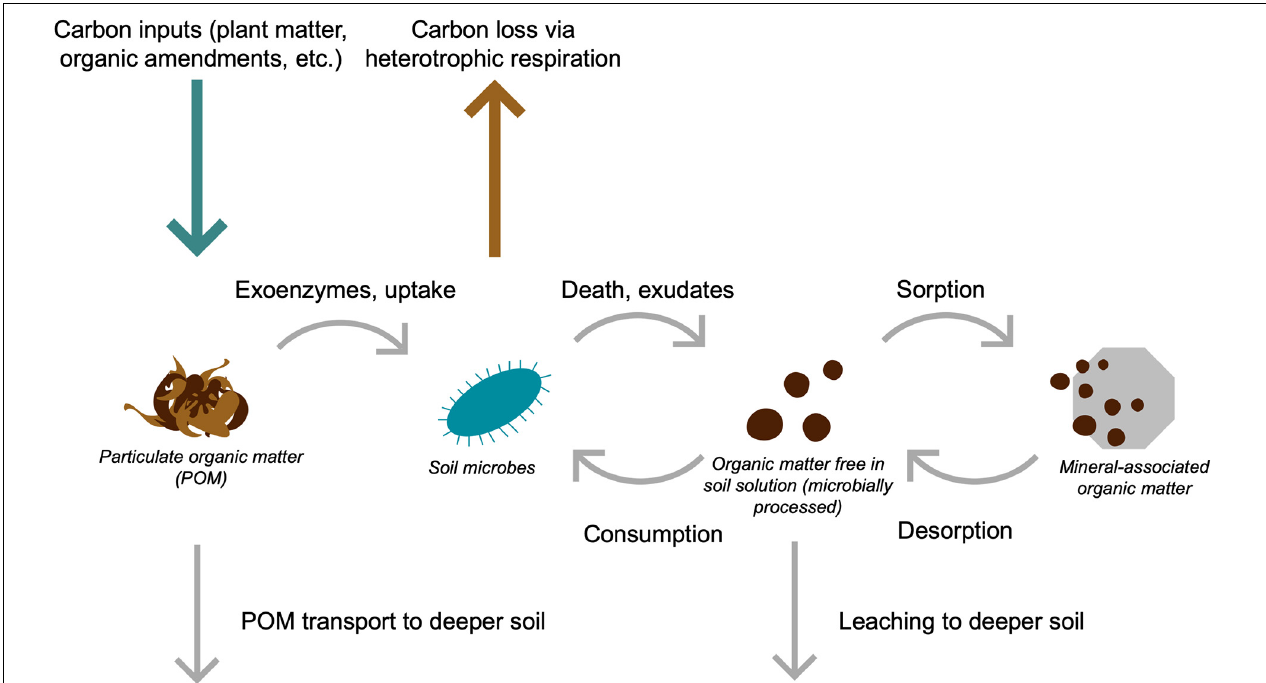
FIGURE 1 | Conceptual illustration of soil carbon (C) flows. Carbon enters soil mainly via plant inputs (green arrow) and is lost via heterotrophic respiration (brown arrow). Plant C inputs are the precursor to particulate organic matter (POM), which can be depolymerized by microbes and taken up into biomass, or transported deeper into the soil profile as particulate matter. Microbial depolymerization, exudation, and turnover releases microbially processed C, which is free in soil solution and can sorb onto mineral surfaces to produce mineral-associated organic matter (MAOM). Mineral-associated organic matter can de-sorb from mineral surfaces and taken back up into microbial biomass or be transported to deeper soil profiles via leaching. Over time, these cycling processes result in the movement of both microbially processed C and POM into increasingly deeper soil horizons.